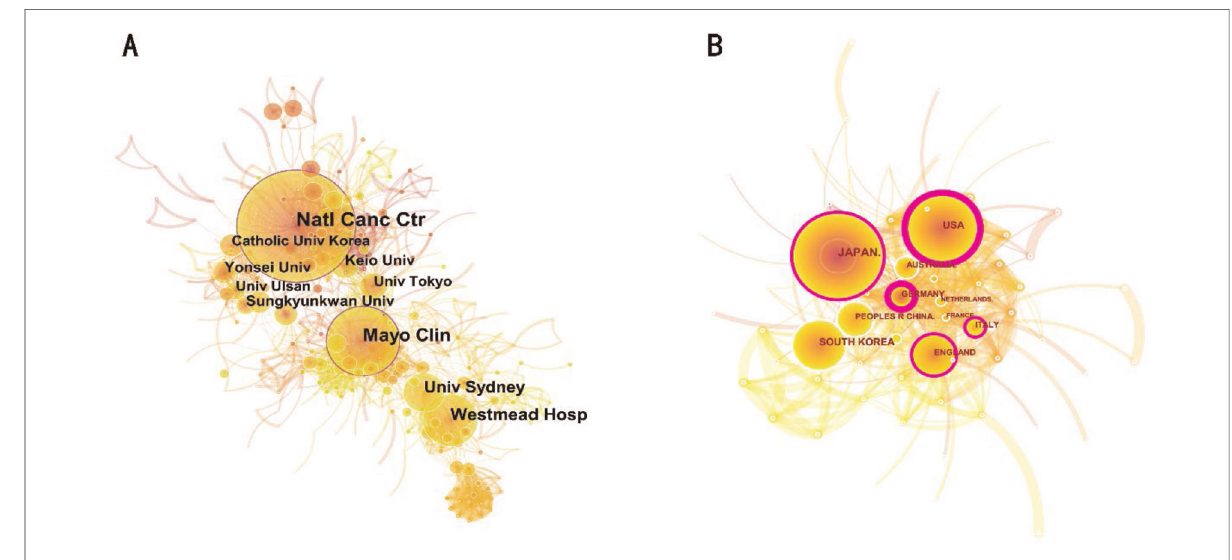
FIGURE 3 ( A ) The co-occurrence map based on countries. ( B ) The co-occurrence map is based on institutions.